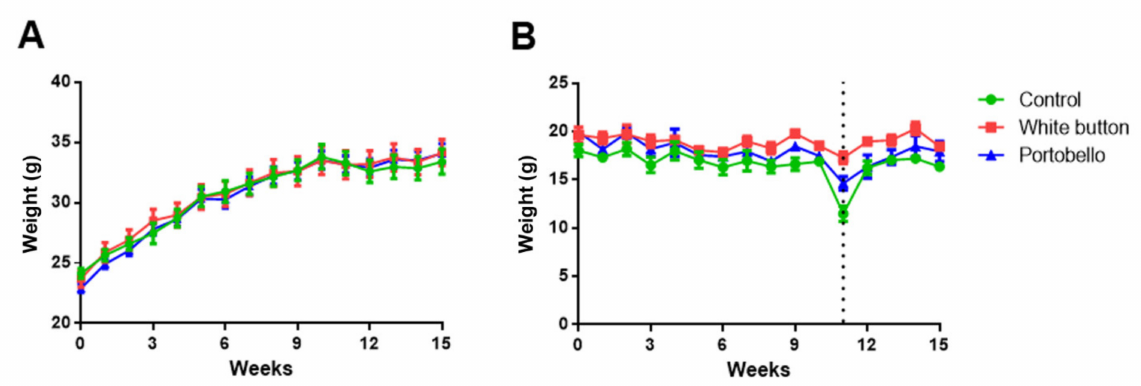
Figure 1. Weight gain ( A ) and food consumption ( B ) by all experimental animals throughout 15 weeks of study. At week 11 (dotted line), animals had to be transferred to larger cages, and a transient diminution in food consumption was observed. Each value represents the mean and standard deviation for all animals ( n = 10 per